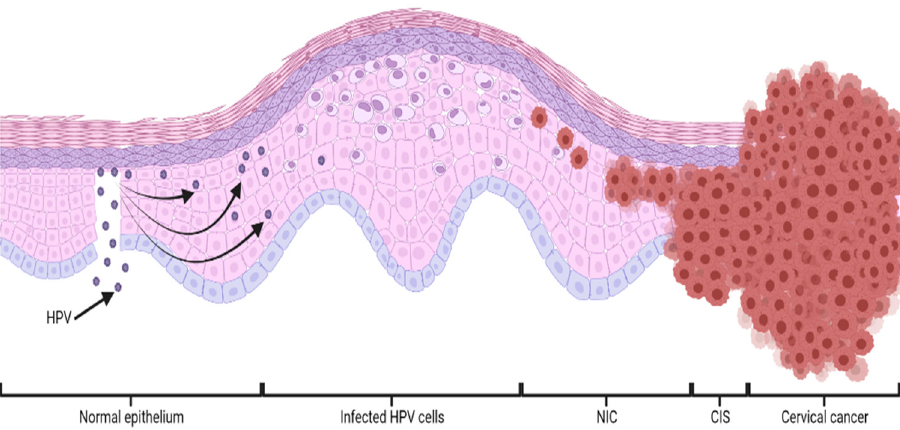
Figure 1. Schematic representation of HPV-mediated cervical epithelial basal cell infection over time. HPV (human papilloma virus); NIC (neoplasm); CIS (carcinoma in situ).